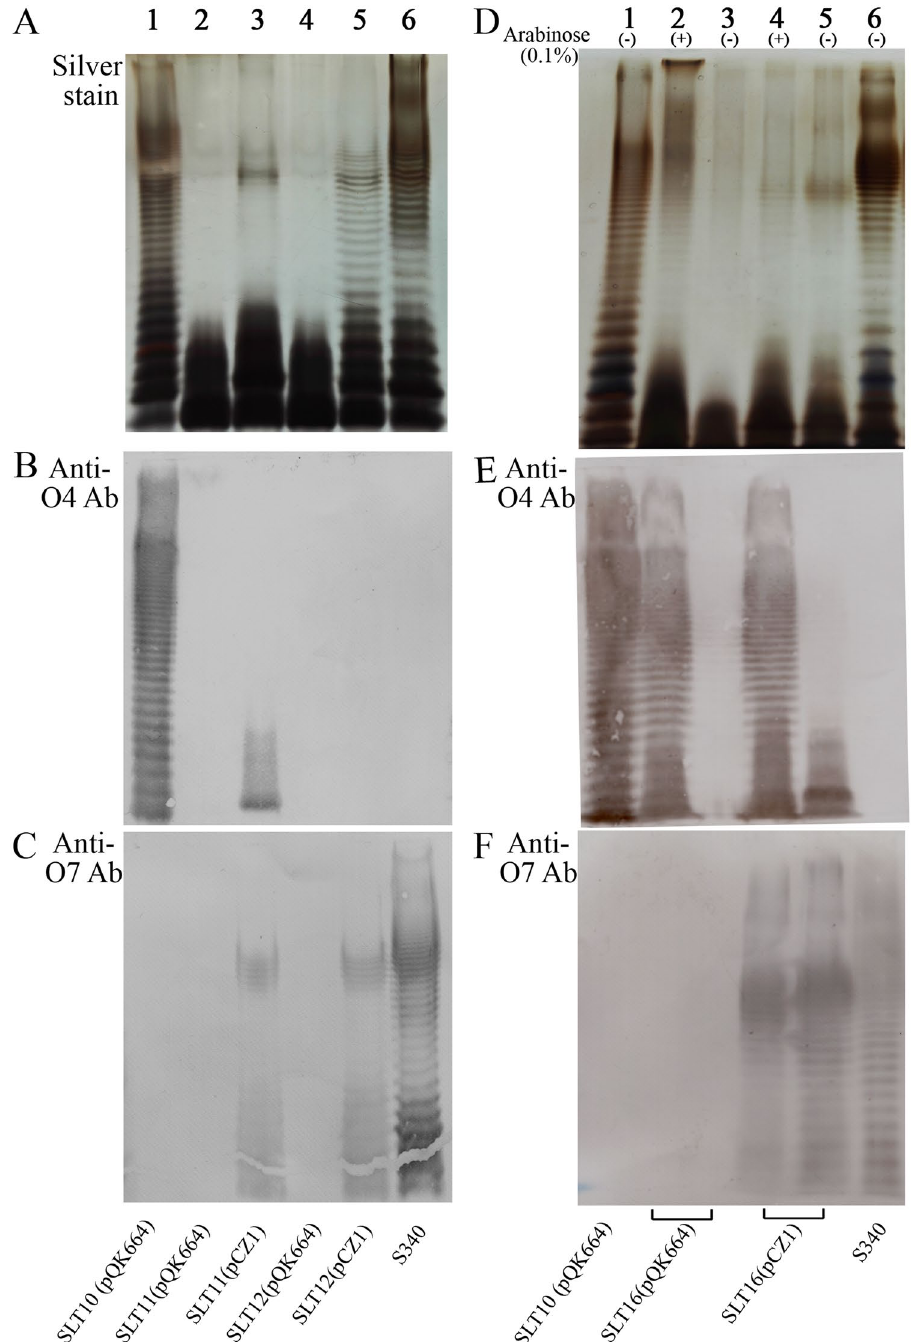
Figure 1. LPS analysis by silver-stain and Western immunoblotting. ( A , B and C ). LPS extracted from Salmonella Typhimurium SLT10 (pQK664) (lane 1), SLT11 (pQK664) (lane 2), SLT11 (pCZ1) (lane 3), SLT12 (pQK664) (lane 4), SLT12 (pCZ1) (lane 5) and Salmonella Choleraesuis S340 (lane 6) was subjected to SDS-PAGE followed by silver staining ( A ) and immunoblotting analysis using O:4-specific antisera ( B ) and O:7-specific antisera ( C ). ( D , E and F ) LPS extracted from SLT10 (pQK664) (lane 1), SLT16 (pQK664) grown with arabinose (lane 2) or without arabinose (lane 3), SLT16 (pCZ1) grown with arabinose (lane 4) or without arabinose (lane 5) and S340 (lane 6) was subjected to SDS-PAGE followed by silver staining ( D ) and immunoblotting using O:4-specific antisera ( E ) and O:7-specific antisera ( F ). Each lane corresponds to LPS from 10 8